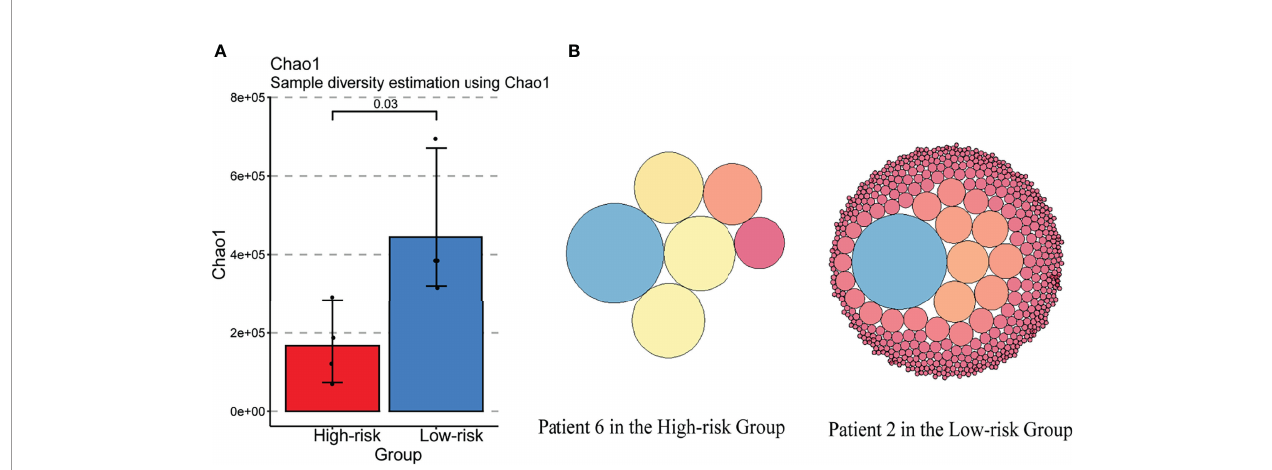
FIGURE 4 | TCR diversity was decreased in the “ High-risk ” group. (A) Changes in the TCRB diversity Chao1 in “ High-risk ” and “ Low-risk ” groups. (B) Changes of TOP25% clonotypes in the two representative patients of “ High-risk ” and “ Low-risk ” groups. Each circle indicates a clonotype. The size of the circle represents the amount of the clonotype.